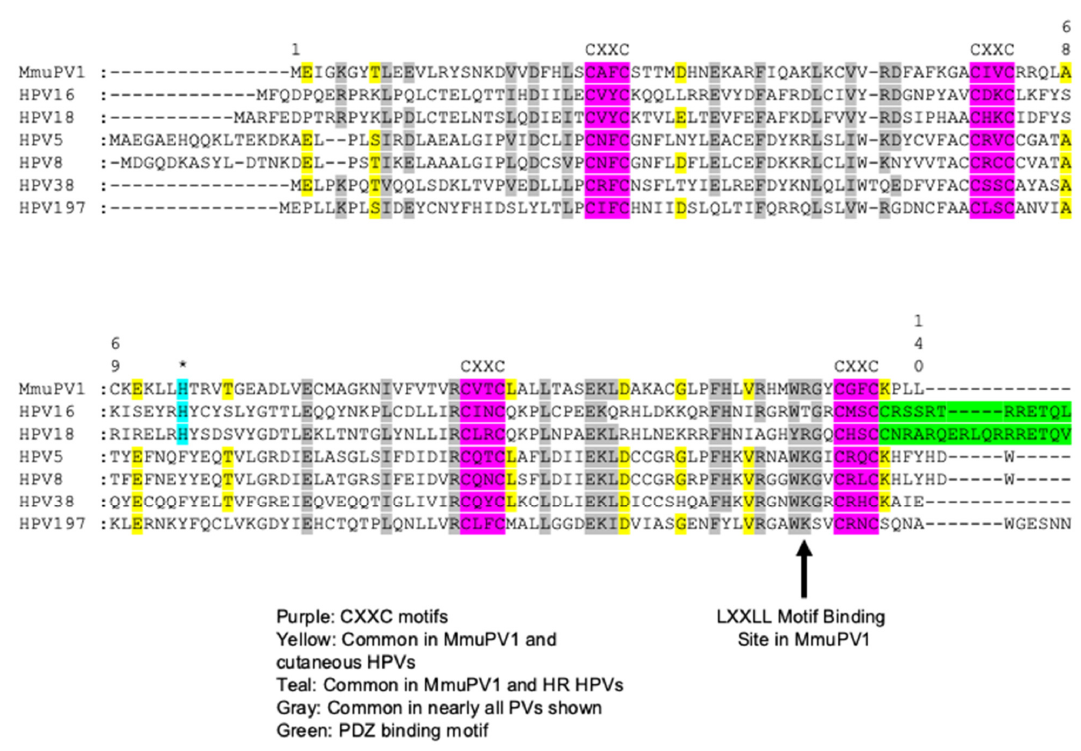
Figure 1. Alignment of MmuPV1 E6 protein to cancer associated HPV E6 proteins. Amino acid sequence alignment of the MmuPV1 E6 protein with E6 proteins encoded by notable cancer associated HPVs including the high-risk α -HPV16 and HPV18, the EV-associated HPVs 5, 8, and 38, and the cutaneous γ -HPV-197. The positions of the four C-X-X-C (C, cysteine; X, any amino acid) motifs which bind Zn2+ amino acid sequence in MmuPV1 E6 are conserved with the HPV E6 proteins (highlighted in purple). MmuPV1 E6 does not contain the PDZ binding domain present in the high-risk mucosal HPV E6 proteins (highlighted in green). A number of amino acids are conserved between MmuPV1 and all the HPV genomes (highlighted in grey). A number of amino acids are conserved between the cutaneous HPV E6 proteins and MmuPV1 E6 as predicted as MmuPV1 is phylogenetically more closely related to the cutaneous HPVs (highlighted in yellow). There was a single instance where an amino acid in MmuPV1 E6 was exclusively shared with the high-risk mucosal HPV E6 proteins (highlighted in teal and asterisk above). A critical amino acid for LXXLL motif binding in MmuPV1 is indicated with the arrow.